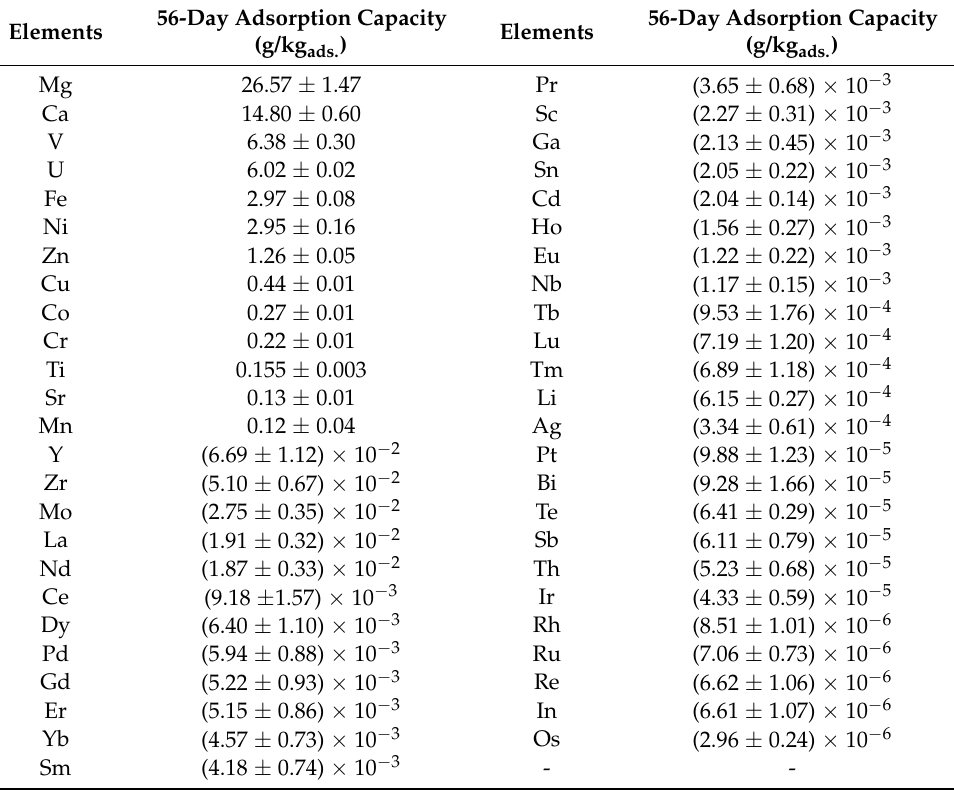
Table 3. The adsorption capacities of different elements on the amidoxime–carboxylate containing polymer fiber (Sequim Bay seawater at 20 ◦ C, 56 days exposure).